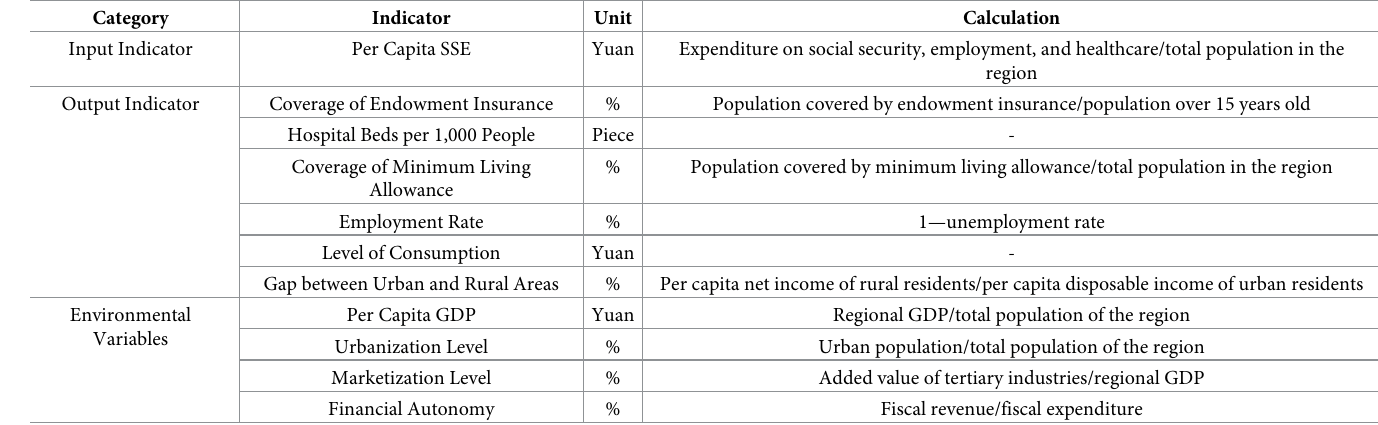
Table 1. Input and output indicators and environment variables.